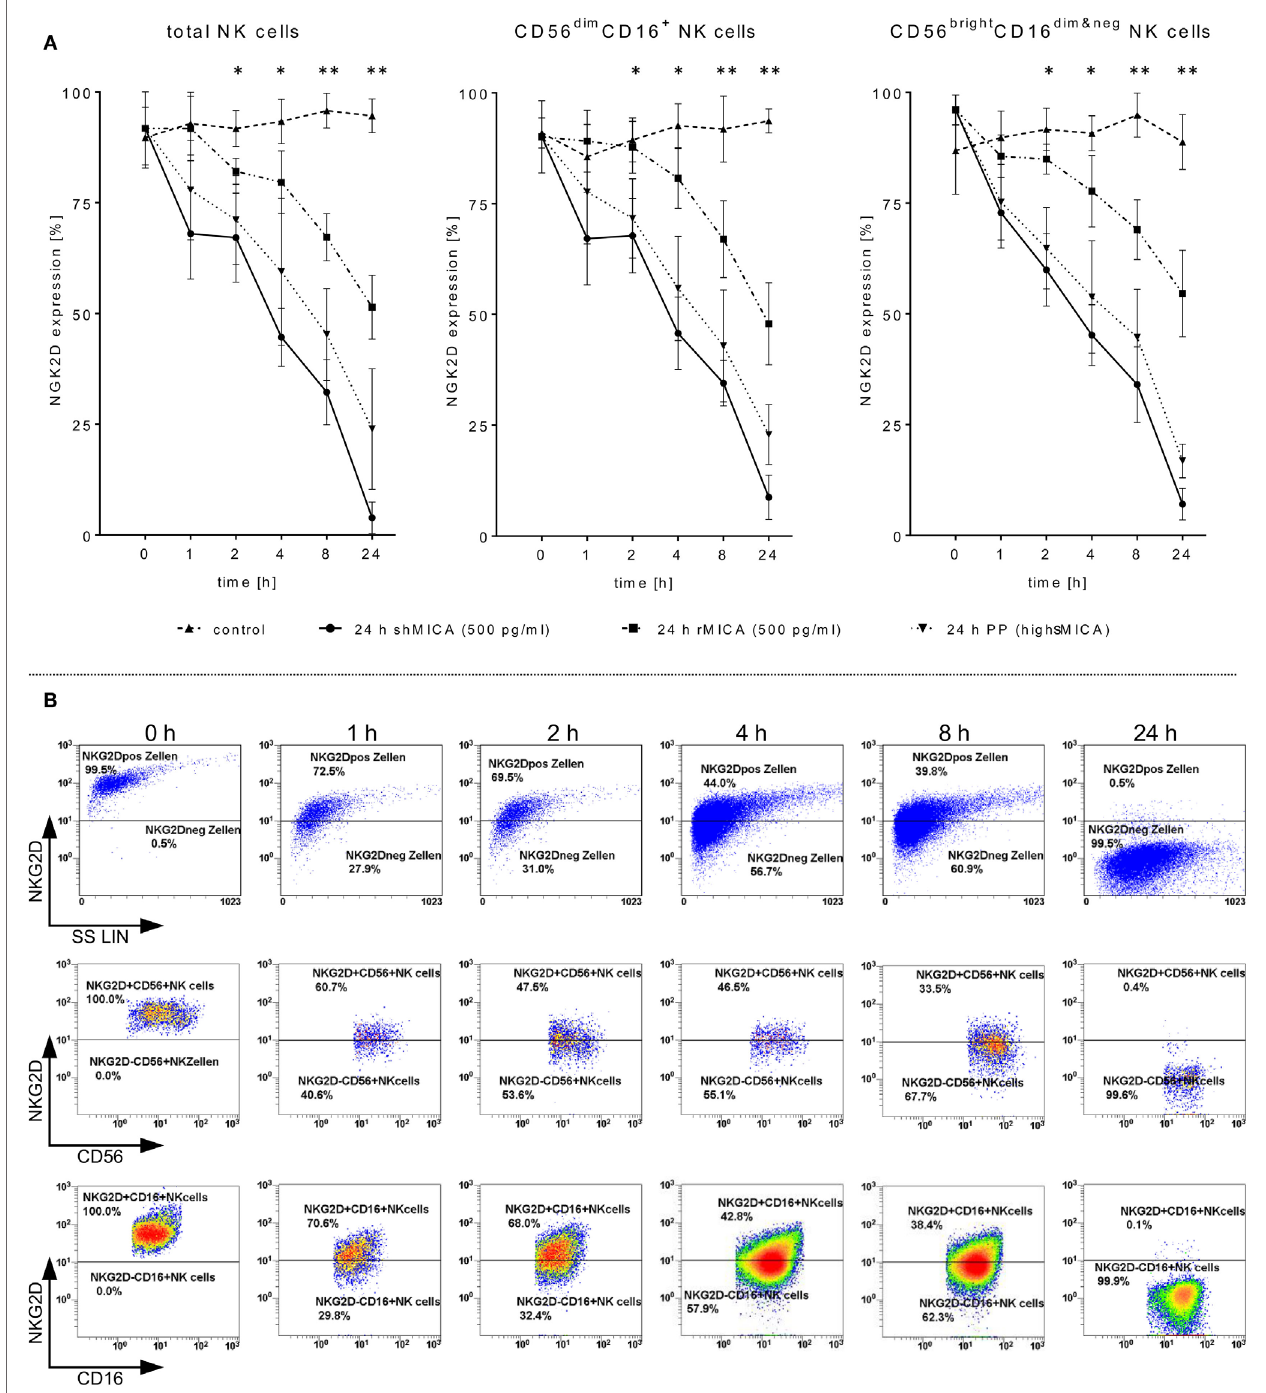
FigUre 2 | impact of sMica on nKg2D surface expression and nKg2D-mediated nK cell cytotoxicity against hnscc cells . Isolated CD56 + /CD3 − NK cells from untreated HNSCC patients ( n = 5) were stimulated for 9–12 days with 1000 IU/ml IL-2. (a) Effect of high sMICA levels on NKG2D surface expression. IL-2 activated patient NK cells were incubated (37°C, 5% CO 2 ) at the indicated points of time with shMICA (500 pg/ml), rMICA (500 pg/ml) and patient plasma containing high MICA levels (PP, range: 220.9–870.7 pg/ml). The NKG2D expression levels on total NK cells and both CD56 dim /CD16 + and CD56 bright /CD16 dim&neg NK subsets were compared to non-treated control NK cells. (B) Phenotypical analyses on time-dependent impact of shMICA on NKG2D surface expression were determined by FCM. Exemplarily depicted here are representative dot plots for one time-dependent